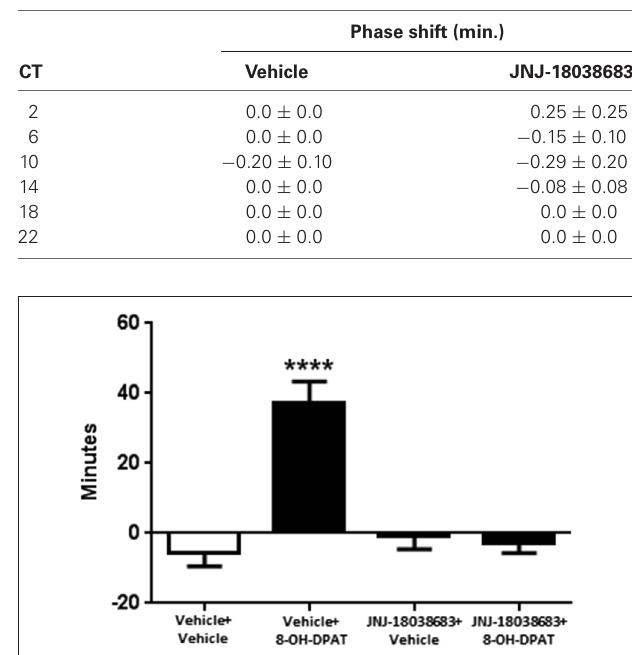
Table 1 | Phase response curve following the administration of the 5-HT7 receptor antagonist JNJ-18038683 (10 mg/kg, i.p.) at various circadian times .